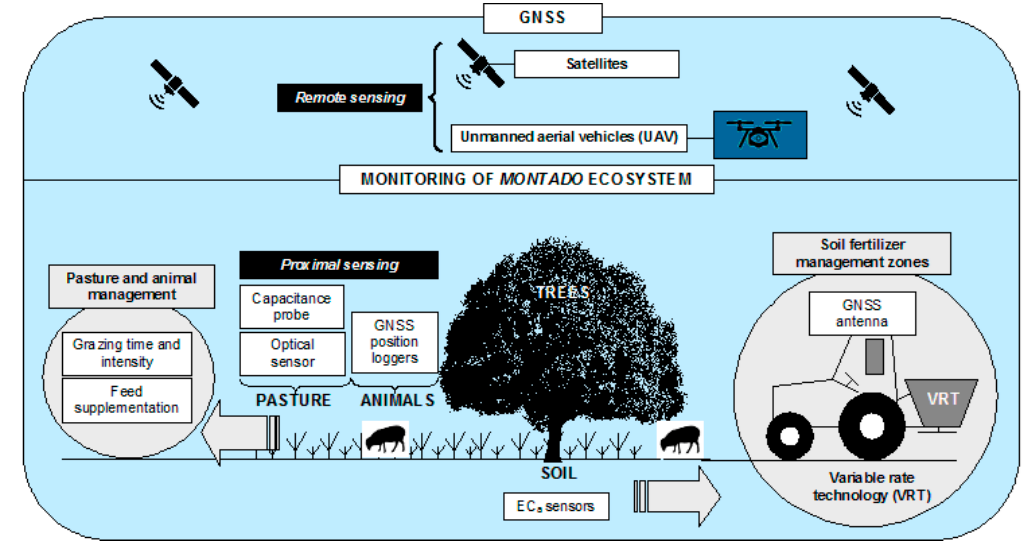
Figure 23. Global overview of technology contribution to montado ecosystem management.